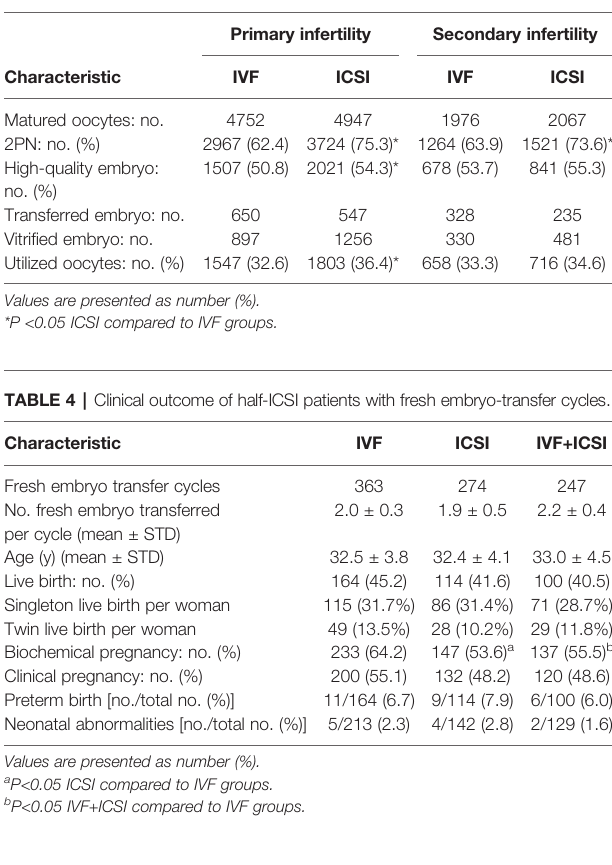
TABLE 6 | Embryo and clinical outcome of 89 cycles of complete IVF infertility